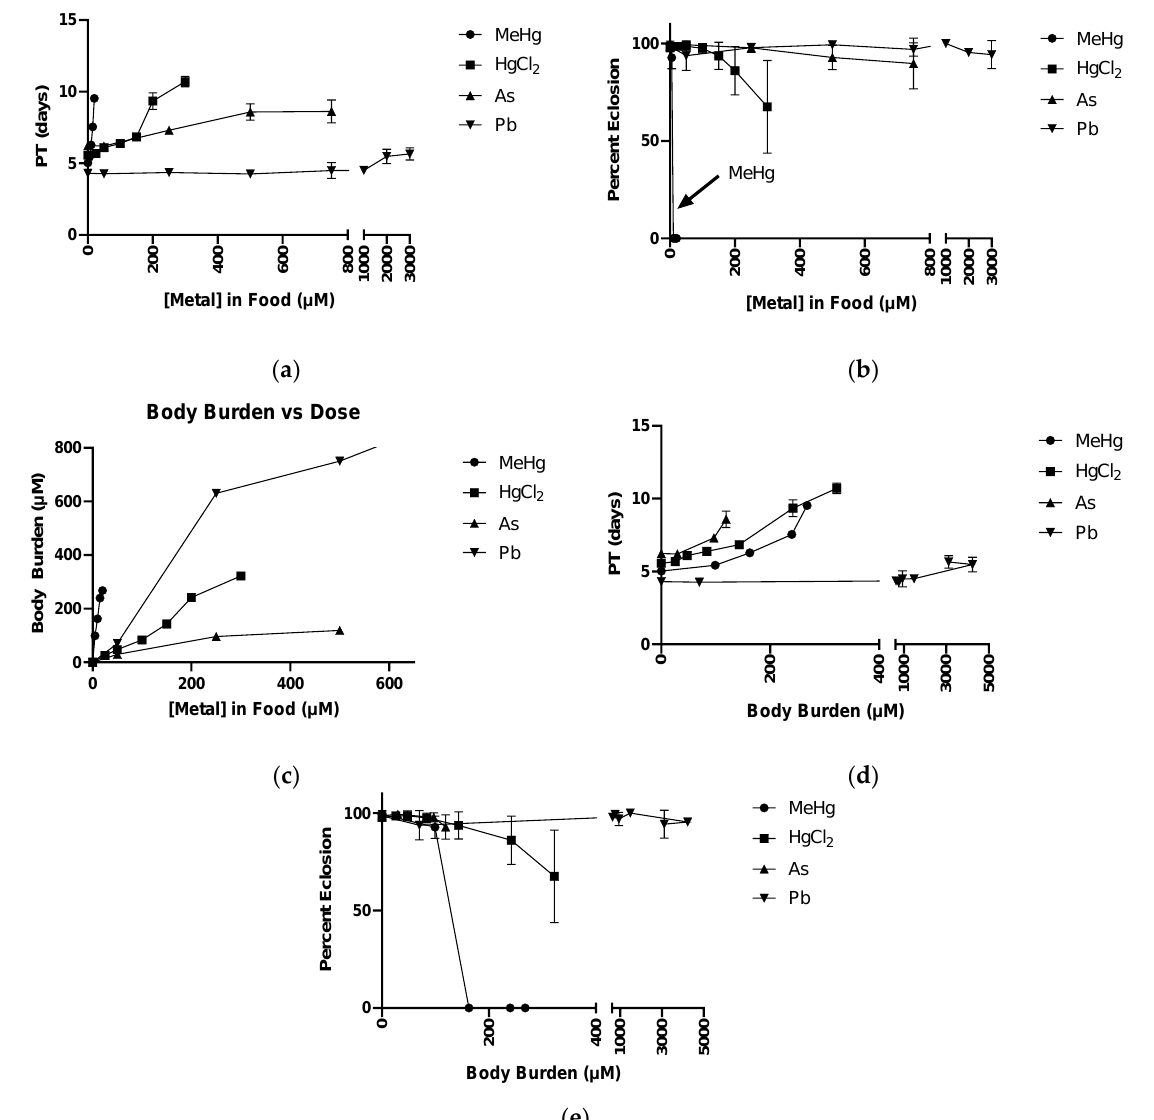
Figure 5. Dose response with respect to body burden for MeHg, HgCl 2 , As, and Pb. ( a ) Pupariation Time (PT) versus Food Dose: pupariation delays induced by all four metals at concentration ranges tested. ( b ) Pharate Adult Eclosion versus Food Dose: eclosion failure induced by all four metals at concentration ranges tested. ( c ) Body Burden versus Food Dose: internal dose of each metal for each treatment in food. A more efficient accumulation of each metal is represented by a steeper slope. ( d ) PT versus Body Burden: pupariation delays caused by each metal while accounting for internal dose. ( e ) Pharate Adult Eclosion versus Body Burden: internal dose of each metal impacts the ability to complete eclosion.